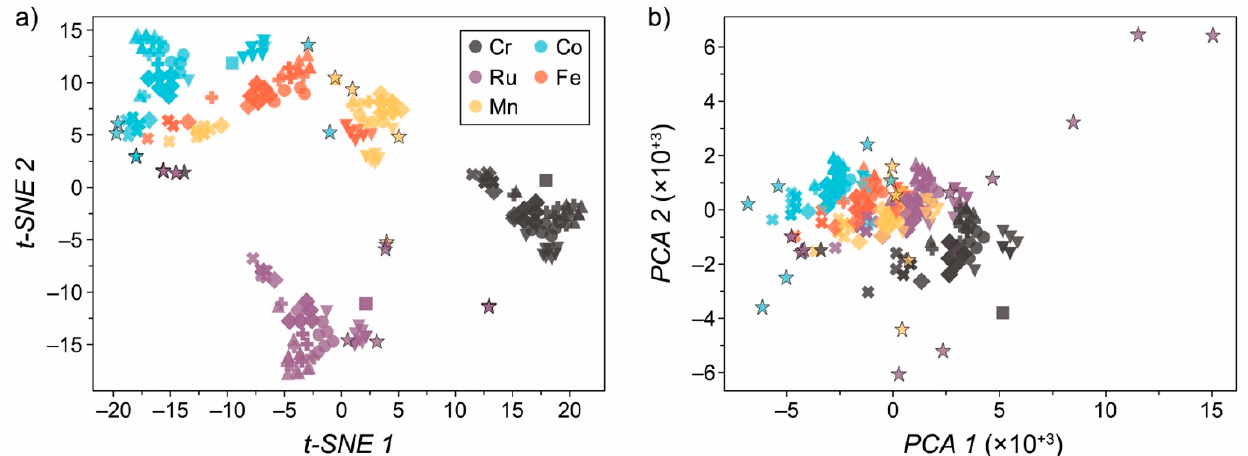
Figure 5. Dimensionality reduction via ( a ) t-SNE and ( b ) PCA analyses applied to the set of complexes under study. Points denoted by a star and black outline are taken from the tmqm dataset [29], which is a representative slice of the Cambridge Structural Database. Note that these data points are not included in Figure 2a.